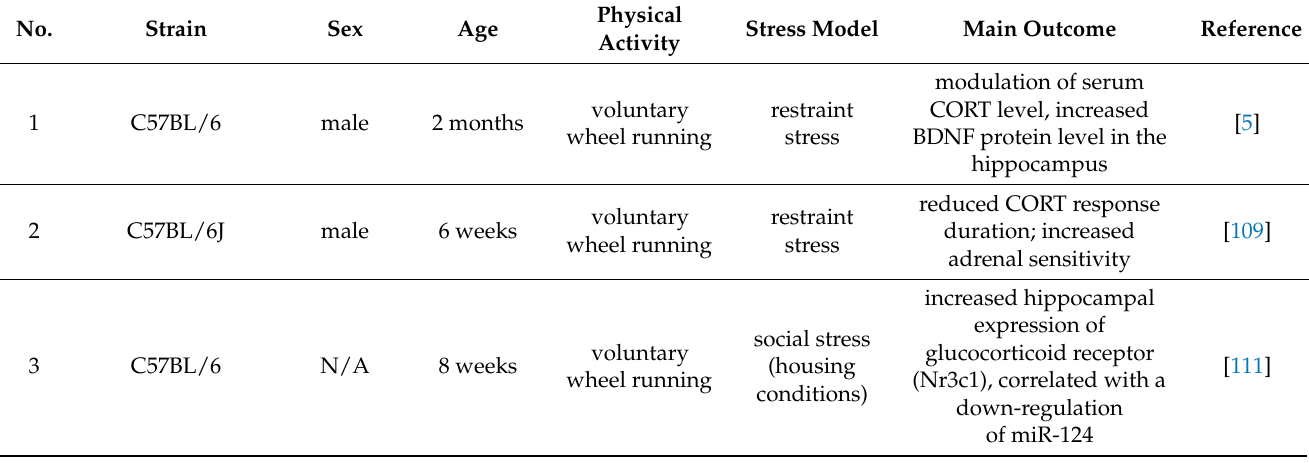
Table 4. Summary of animal research focusing on HPA (hypothalamic-pituitary-adrenal) axis